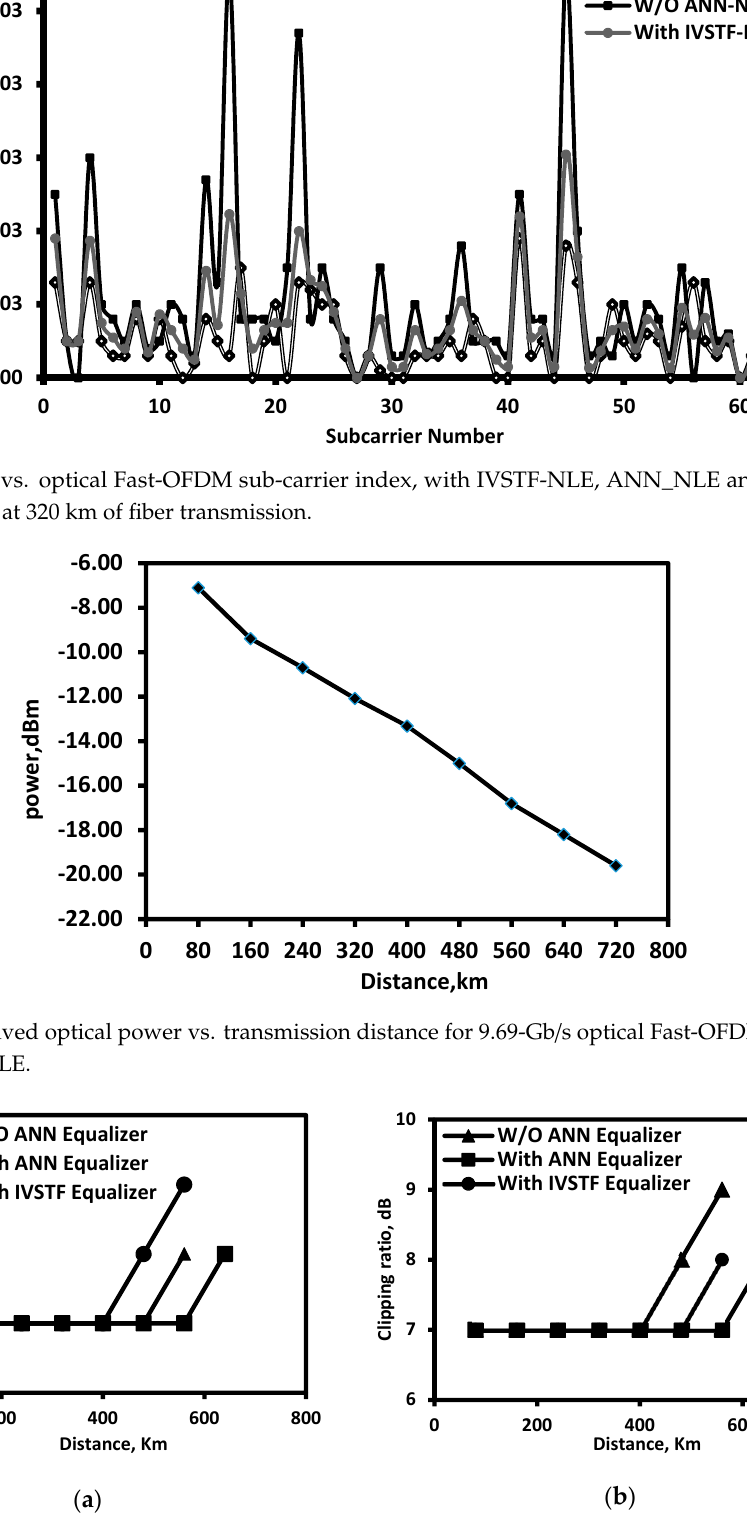
Figure 7. Effect of DAC/ADC components on 4-ASK optical Fast-OFDM transmission performance with the use of IVSTF equalizer, with ANN equalizer and W/O ANN at a signal bit rate of 9.69-Gb/s for a transmitted power of − 6 dBm: ( a ) Quantization bit vs. Distance. ( b ) Clipping ratio vs. Distance.